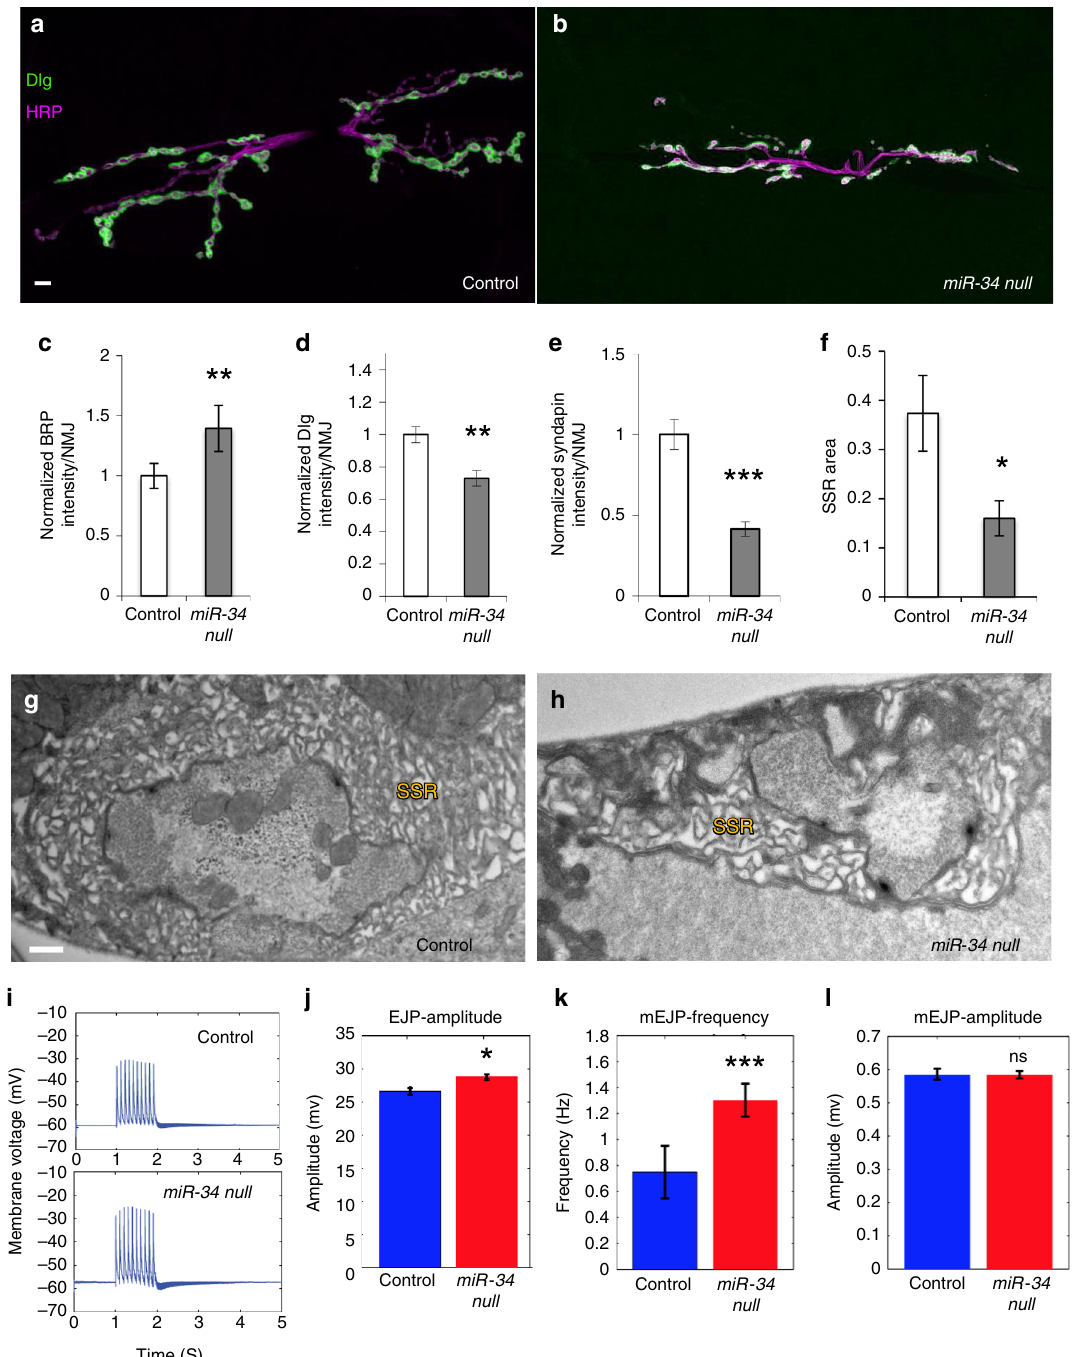
Fig. 2 miR-34 is required for both presynaptic and postsynaptic development. a , b Scanning confocal images of the M6/7NMJ (segment A2) were stained for the presynaptic membrane (HRP, magenta), and postsynaptic (Dlg, green). a w 1118 control animal; b miR-34 null. Scale bar (10 µ m) applies to panels a and b . c – e Intensity quanti fi cation of synaptic biomarkers at the M6/7NMJ are shown for control and miR-34 null (** indicates p -value ≤ 0.01; *** p -value ≤ 0.001). c Presynaptic T-bar marker Brp imaged using 3-D SIM for high spatial resolution ( n = 6 control and miR-34 NMJs). d , e Postsynaptic marker Dlg ( n = 21 control and miR-34 NMJs) and Syndapin ( n = 26 control and n = 23 miR-34 NMJs), respectively, imaged with confocal microscopy. f Quanti fi cation of SSR area from TEM images (* indicates p -value ≤ 0.05) ( n = 12 boutons from 3 w 1118 animals; n = 16 boutons from 7 miR-34 null animals). g , h TEM micrographs of type 1 boutons from the M6/7NMJ; Scale bar in g , 500 nm. g A w 1118 control shows presynaptic vesicles are evenly distributed and the postsynaptic SSR is organized into distinct membrane folds. h A miR-34 null NMJ is shown for comparison. i Electrophysiological recordings from control and miR-34 null M6/7NMJs. Input resistance wasnot signi fi cantly different ( p = 0.4178) between control (7.9 + 0.4 M Ω ; n = 7) and miR-34null (8.2 + 0.6 M Ω ; n = 8) by Kruskal – Wallis test. j miR-34 null animals show slight, butsigni fi cant elevation in evoked EJP amplitude compared to control. Error bars indicate ± SEM, (* p -value < 0.05). (* p -value ≤ 0.05). k miniature mEJP frequency was signi fi cantly higher in the miR-34 null (*** p -value ≤ 0.001), but mEJP amplitude was not signi fi cantly (ns) altered in the mutant ( l ). Source data are provided as a Source Data fi